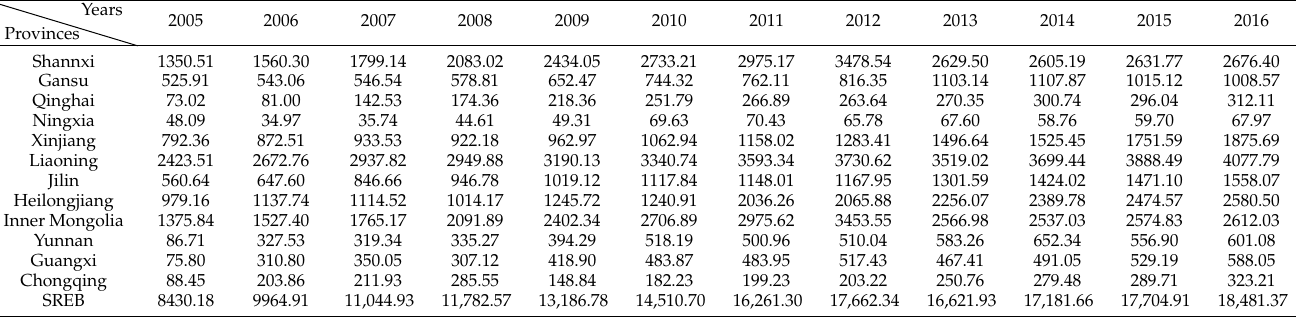
Table 1. Distributions of carbon emissions from the transportation sector in SREB (10 k